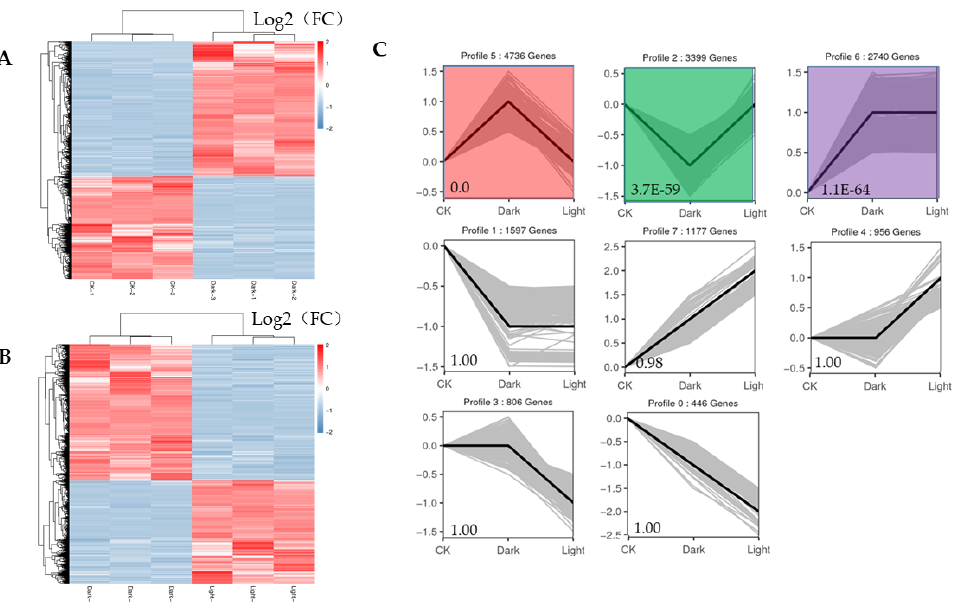
Figure 5. Heatmaps of all DEGs and eight significant expression clusters of all DEGs. ( A ) Heatmap showing the expression profiles of all DEGs between the control and darkness treatments. ( B ) Heatmap showing the expression profiles of all DEGs between the darkness and recovery light treatments. ( C ) The eight expression patterns of DEGs; the cluster names and unigene numbers are shown at the top.